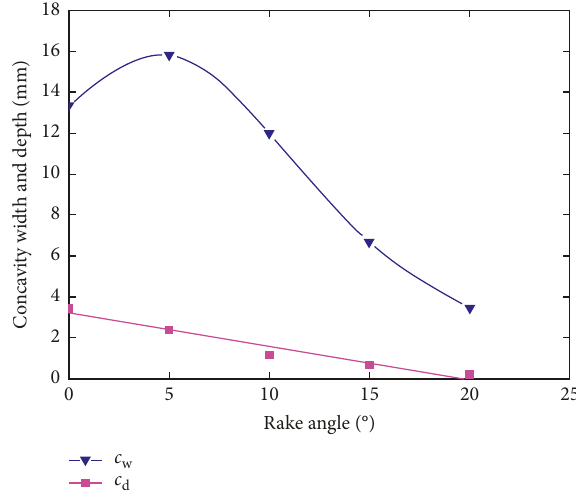
Figure 9: Width and depth of concavities at different rake angles of indenter ( h D 2mm). (cid:28)